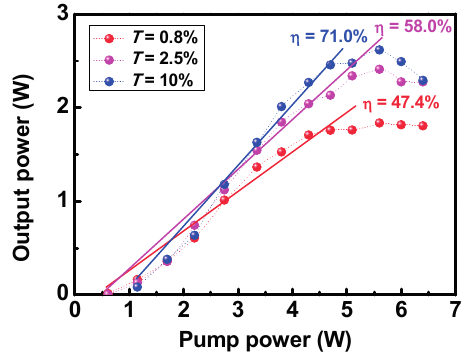
Figure 2. CW output power of the Yb:GYSO laser versus the incident pump power for three OCs with different transmissions (0.8%, 2.5%, and 10%).